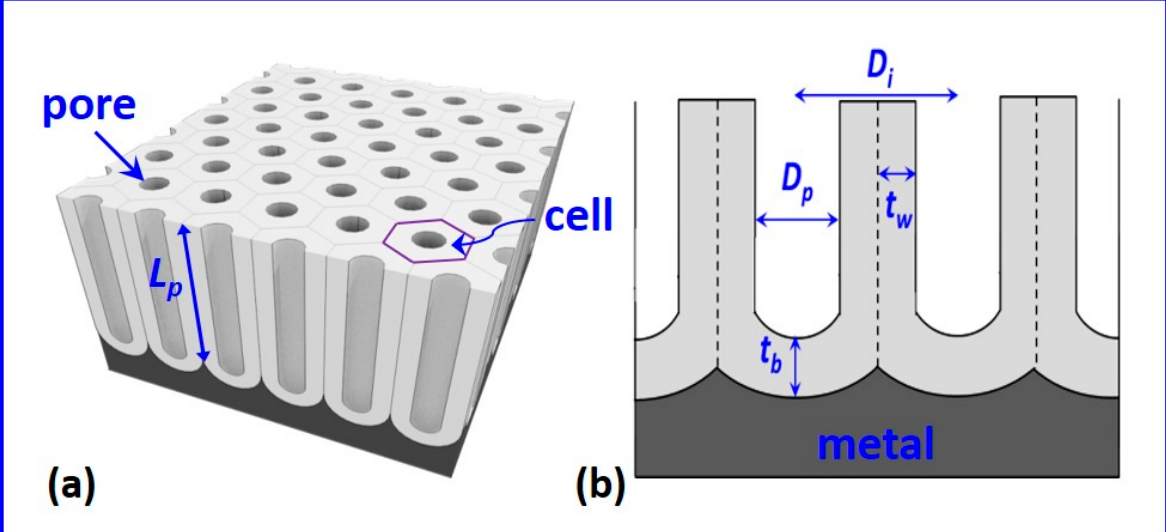
Figure 2. Schematic representation of ( a ) nanoporous anodic alumina (NAA); and ( b ) cross-sectional view; L p —pore length (or thickness of the porous layer), D p —pore diameter, D i —interpore distance, t b —the thickness of the barrier layer, and t w —the pore wall